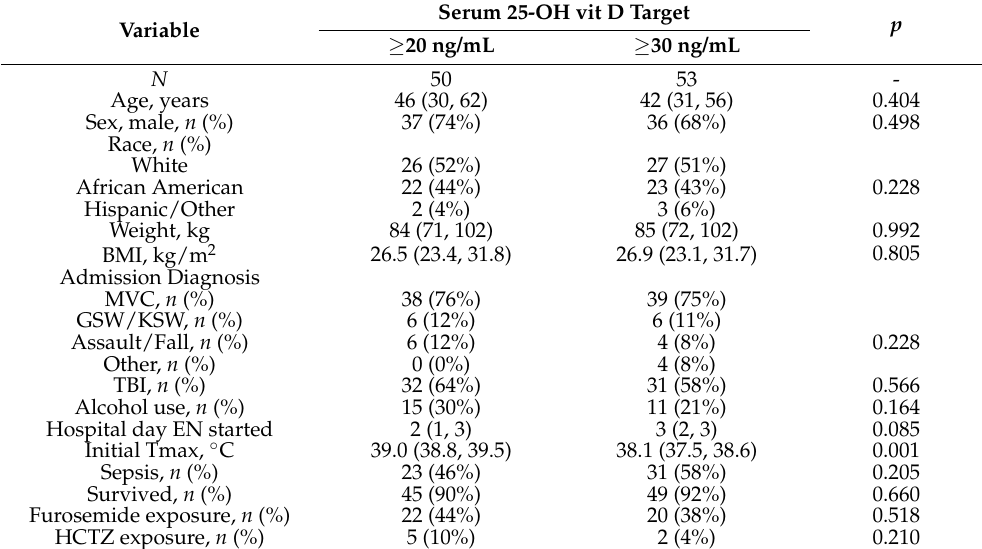
Table 1. Patient